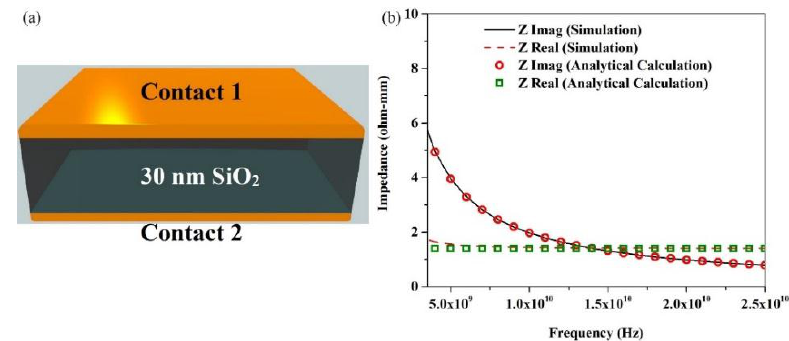
Figure 7. ( a ) Schematic of the capacitor like structure; ( b ) The real and imaginary parts of impedance, estimated from simulations and analytical calculations.